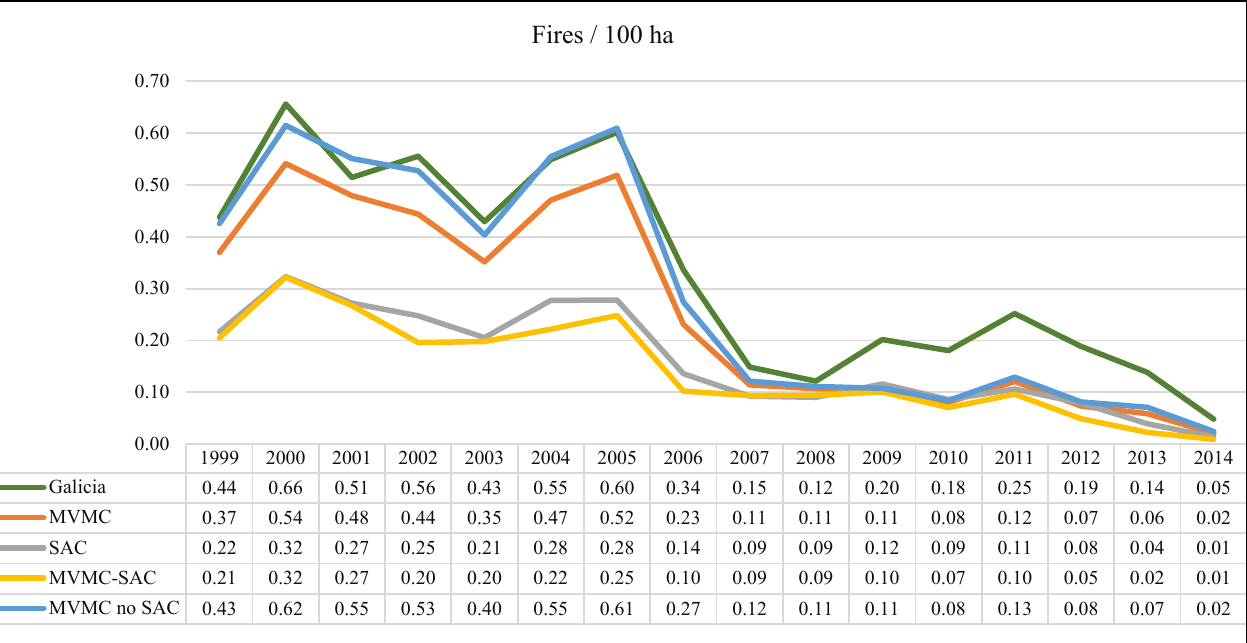
Figure 11. Historical evolution (1999–2014) of the fire rate in each territorial group analysed. After 2004, the rate of forest fires for the different territorial groups analysed tended to converge. A more detailed analysis of the obtained results found that the area burned by fire (AB/fire) increased significantly after 2004 in all territorial categories studied. Interest-